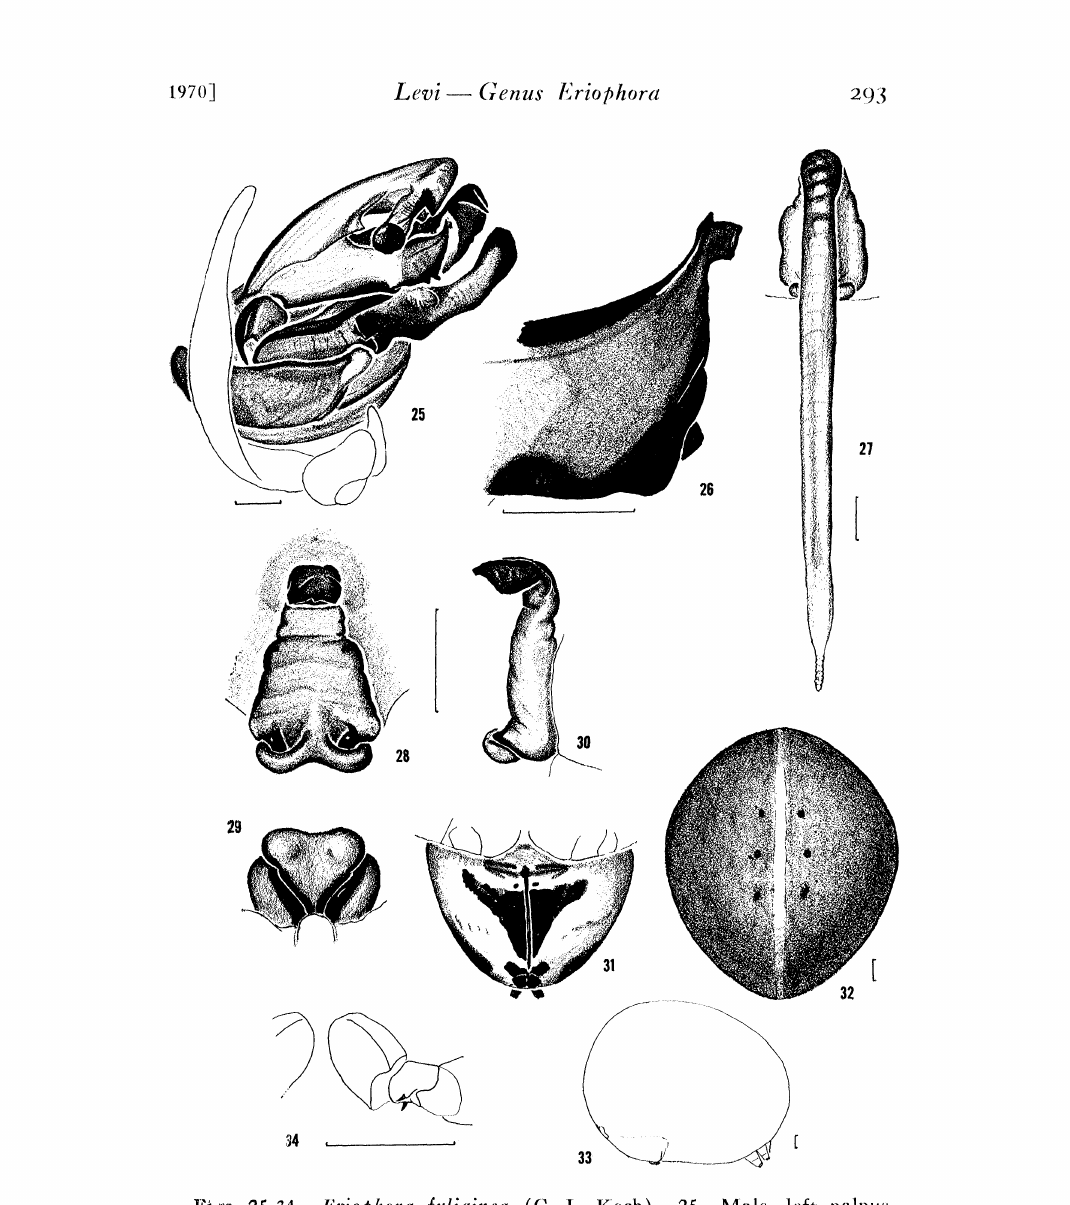
Figs. 25-3. Eriolhora fuliinea (C. L. Koch). 25. Male, left palpus, mesal view. 26. Embolus. 27. Epigynum. 28-30. Base of eIigynum. 28. Ventral. 29. Posterior. 30. Lateral. 31-33. Female, abdomen. 31.. Ventral. 32. ])orsal. 33. Lateral. 3. Male ourth coxa and trochanter. 8ze Indcafors: Fis. 25-30, 0.5 ram. Figs. 31-34,